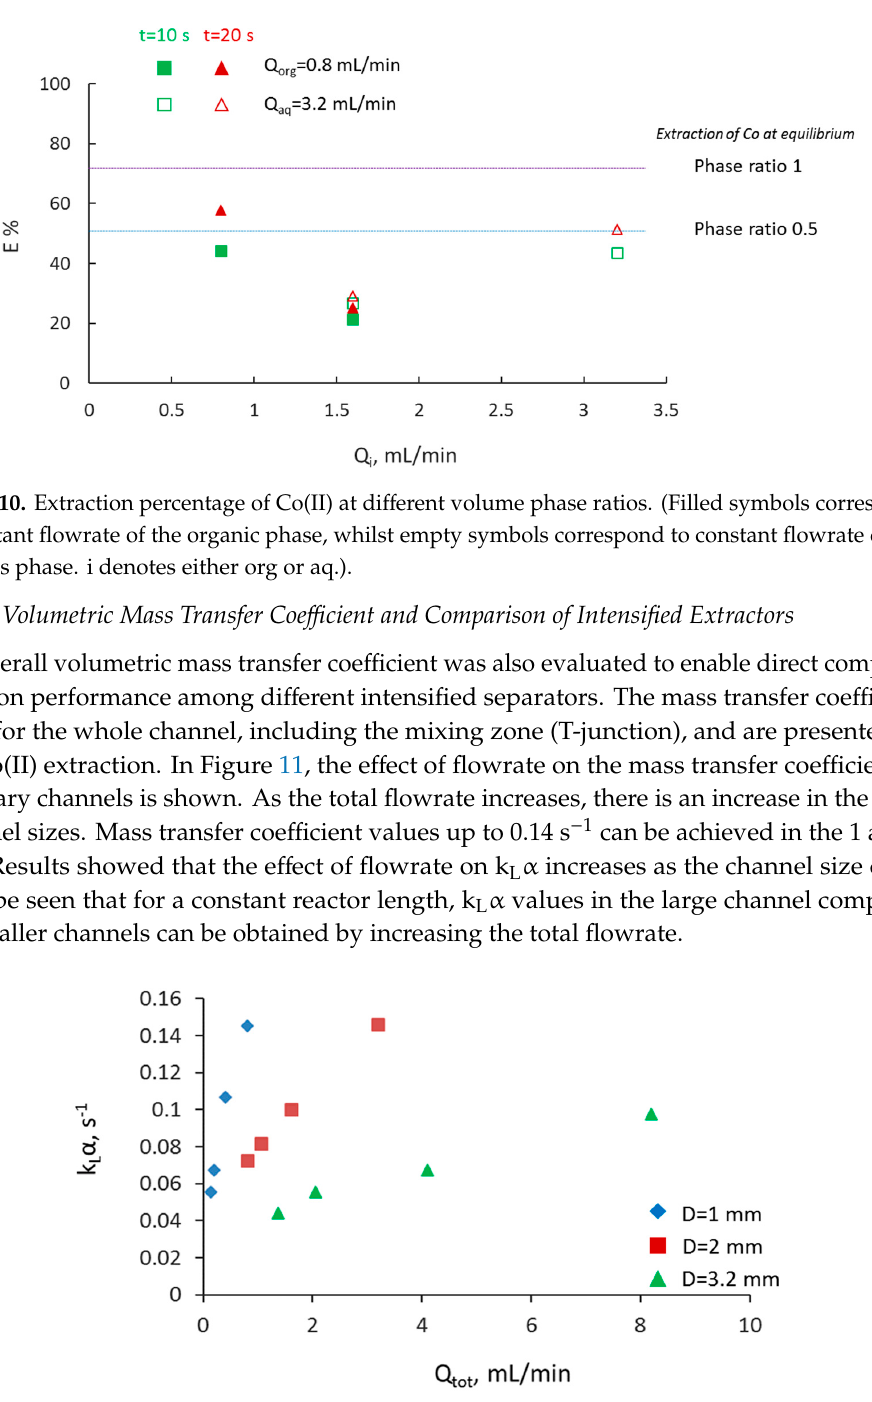
Figure 11. Effect of total flowrate on the overall mass transfer coefficient at different channel sizes and at constant reactor length (L r = 8.5 cm).